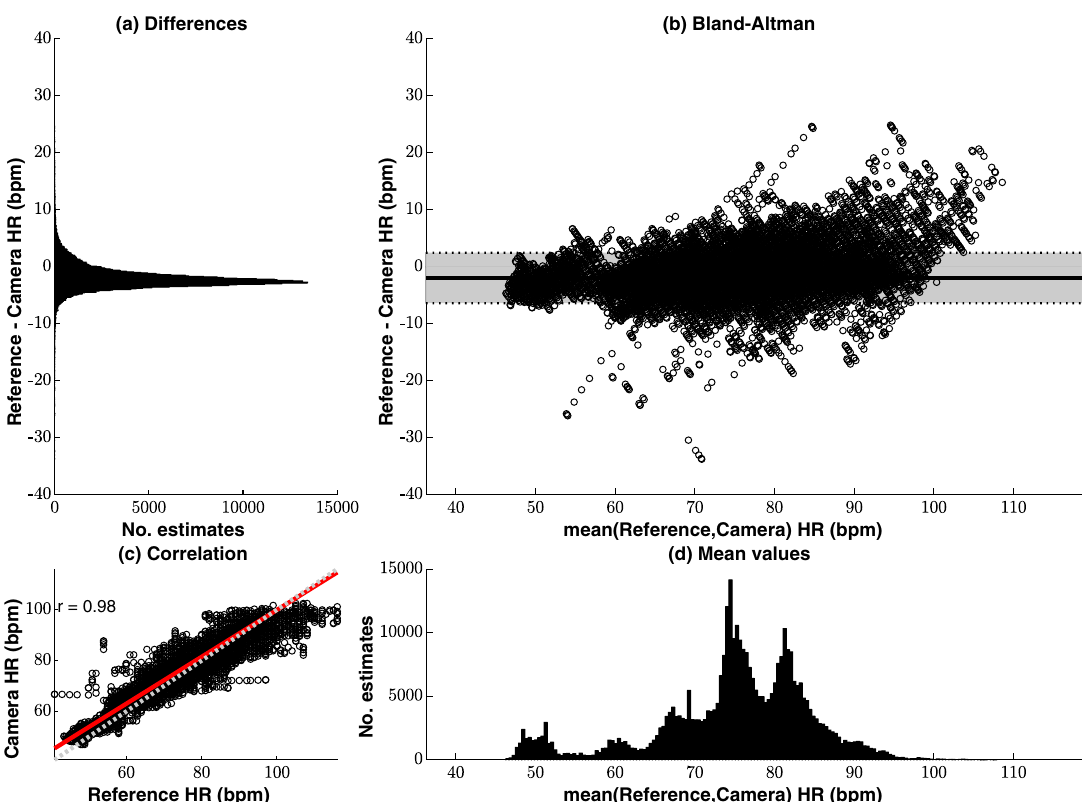
Fig. 1 Agreement between the reference heart rate values (computed from the ECG and PPG) and the camera estimates for the valid video camera data, comprising a total estimated time of approximately 103.0 h. a The differences between the camera and reference monitors are normally distributed. b The Bland-Altman plot presents a minimal sensor bias. c The scatter plot shows high correlation between the two devices, with a Pearson correlation coef fi cient of 0.98. d The distribution of the mean values shows that most of the heart rate estimates are within the expected physiological range for